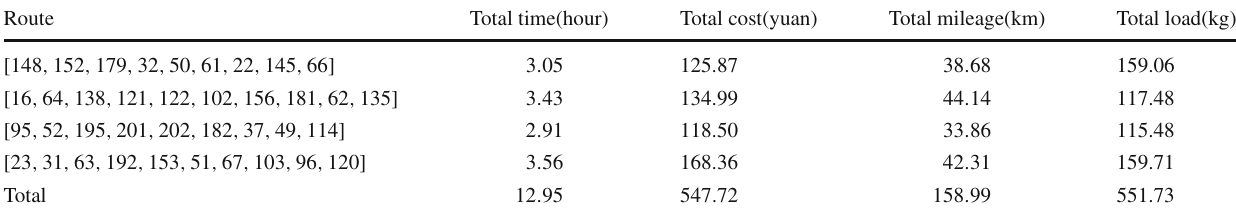
Fig. 6 Clustering results Table 4 Result analysis of region